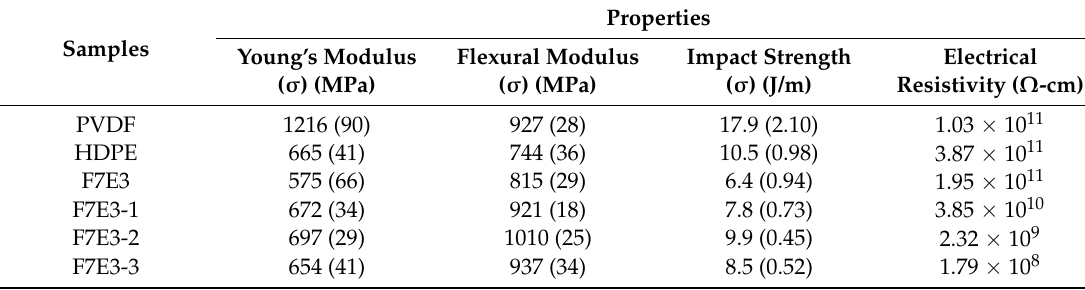
Table 4. Mechanical properties and electrical resistivity of the selected